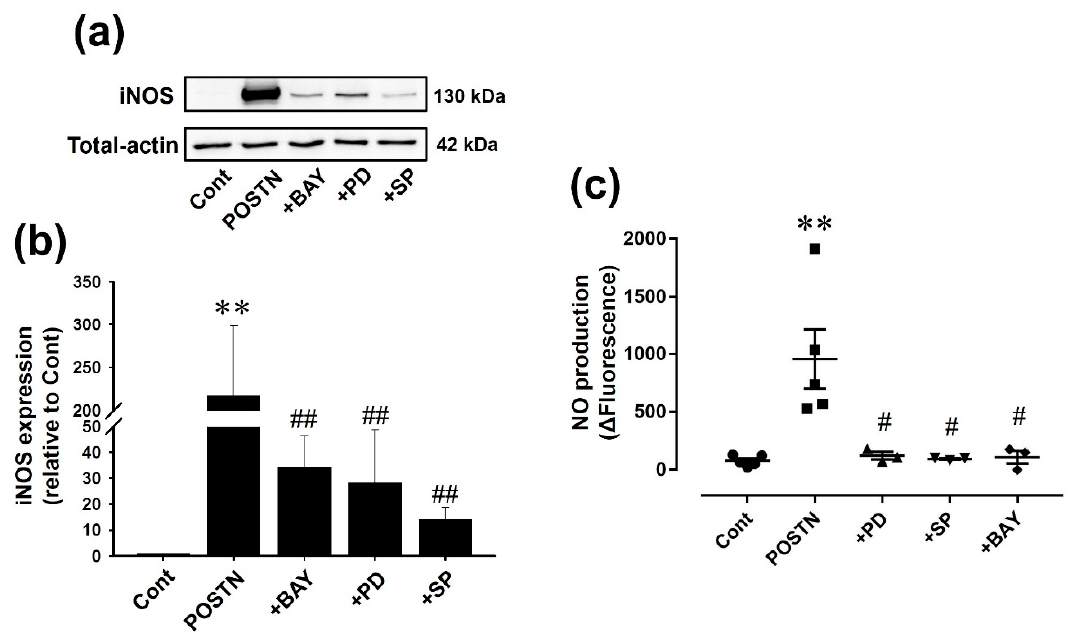
Figure 5. Pharmacological inhibition of inhibitor of kappa B α (I κ B α ), mitogen-activated protein kinase kinase (MEK)/ERK signaling pathway or JNK prevented POSTN-induced iNOS expression and NO production in RVFbs. RVFbs were stimulated with recombinant rat POSTN (1000 ng/mL) or solvent (Cont) for 24 h in the presence or absence of pretreatment with inhibitor of I κ B α (BAY11-7082 (+BAY, 10 µ M)), MEK/ERK signaling pathway (PD98059 (+PD, 50 µ M)) or JNK (SP600125 (+SP, 10 µ M)) for 30 min. The iNOS expression in RVFbs was evaluated by western blotting. ( a ) Representative blots were shown. ( b ) Expression level of iNOS was corrected by total-actin, and the normalized expression relative to Cont was shown as mean ± S.E.M. ( n = 3). NO production was measured by using DAF-2. ( c ) The fluorescence at 120 min after treatment with L -arginine was subtracted by fluorescence at 0 min ( ∆ Fluorescence), and shown as mean ± S.E.M. (Cont, POSTN: n = 5; +BAY, +PD, +SP: n = 3). ** p < 0.01 versus Cont, # , ## p < 0.05, 0.01 versus POSTN.